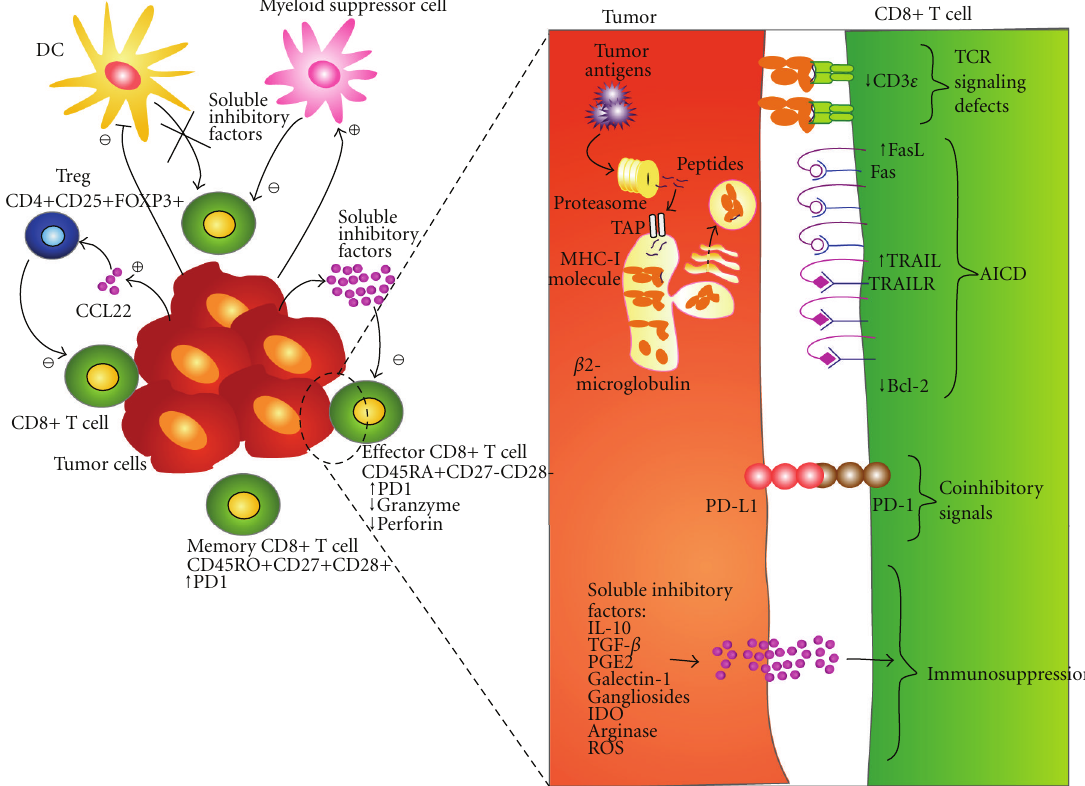
Figure 1: Alterations induced in the CD8+ T-cells by lung cancer. Tumor, stroma, cells, and soluble factors in the microenvironment inhibit DCs recruitment and induce the presence of immune cells with suppressor activity, such as myeloid suppressor cells and Tregs, which results in (1) blocking the di ff erentiation program of CD8+ T-cells keeping them in a memory stage and diminishing the terminally-di ff erentiated CD8+ T-cell subset, (2) reduced expression of cytolytic molecules granzymes and perforin, (3) reduced expression of CD3 ε , altering the signaling pathway through TCR ligation, (4) PD-L1/PD-1 interaction that induces on CD8+ T-cell decreased TCR-mediated proliferation and cytokines production, (5) sensitization of CD8+ T-cell to apoptosis mediated by AICD.